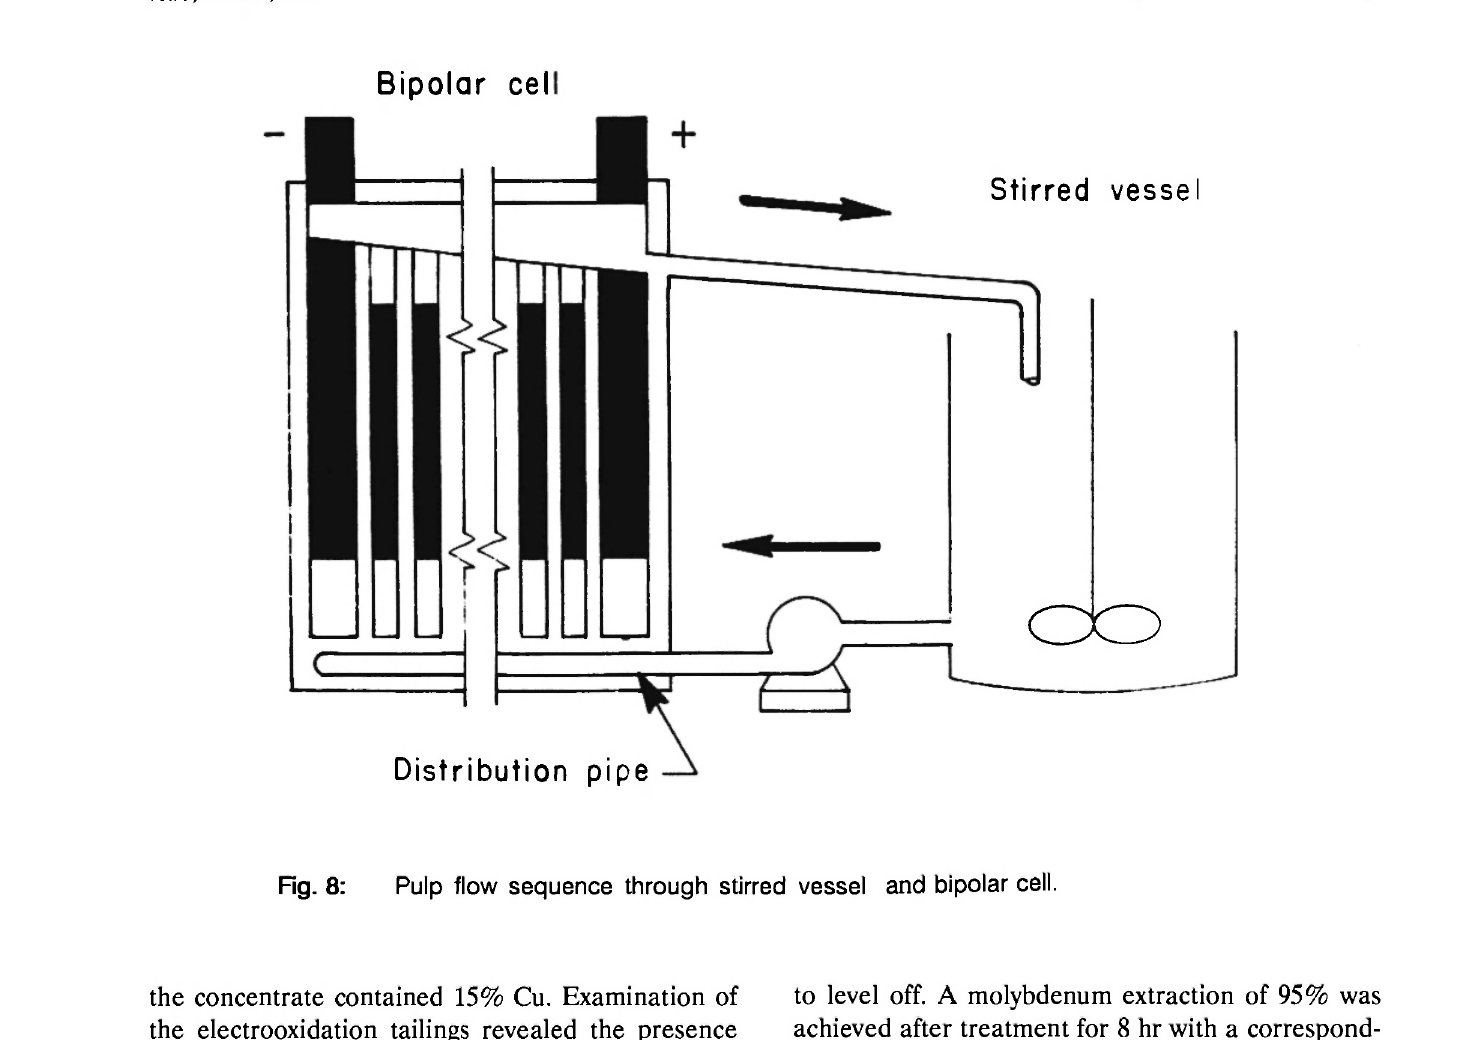
Fig. 8: Pulp flow sequence through stirred vessel and bipolar